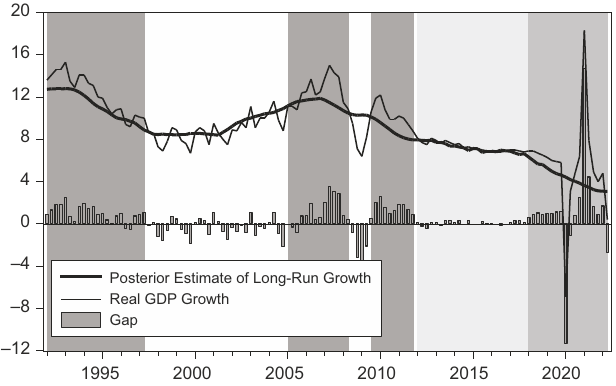
Figure 6. Comparison between the trend and year-on-year real GDP growth